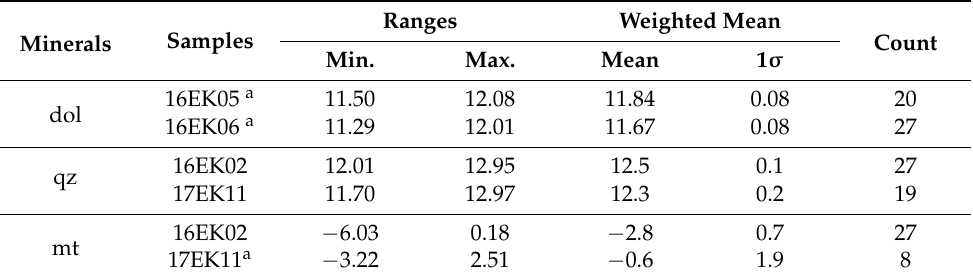
Table 3. Oxygen isotopes ( δ 18 O V-SMOW , ‰) of dolomite (dol), quartz (qz), and magnetite (mt) from the chlorite schist and BIF (analyzed by